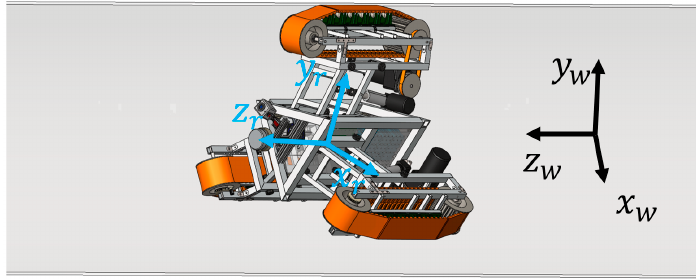
Figure 8. World coordinates and robot coordinates within the tube.